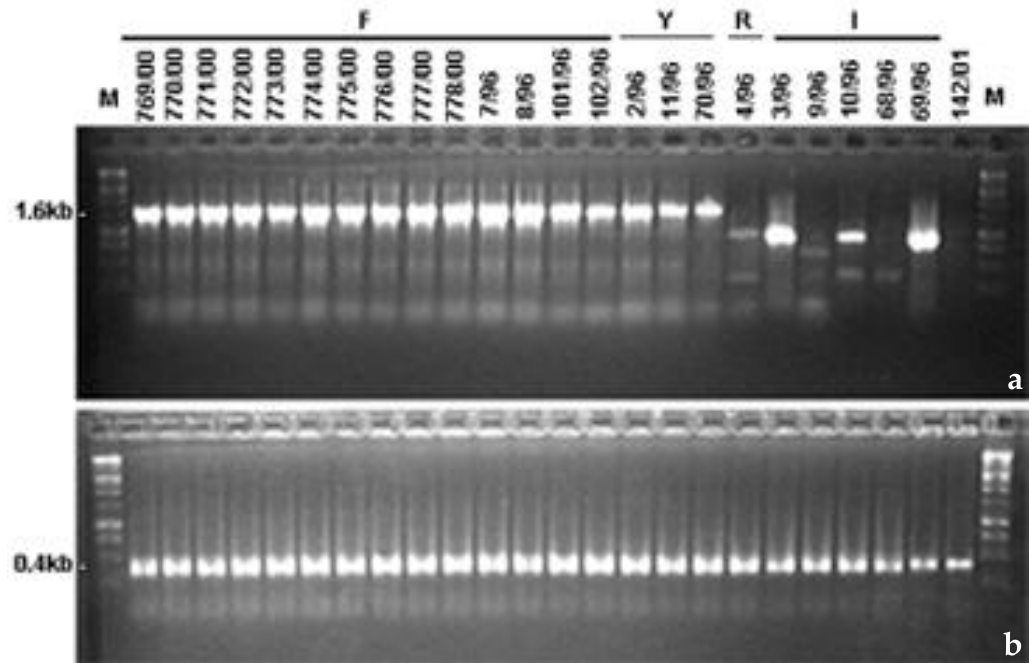
Figure 6. PCR analysis on a set of Diaporthe helianthi isolates. genomic Dnas derived from 23 D. helianthi isolates (14 French F, three Yugoslavian Y, one Romanian R and five Italian I) and an outgroup D. arctii (142/01). a . EPF-EPR specific primers; b. igS-12a and nS1R primers as a